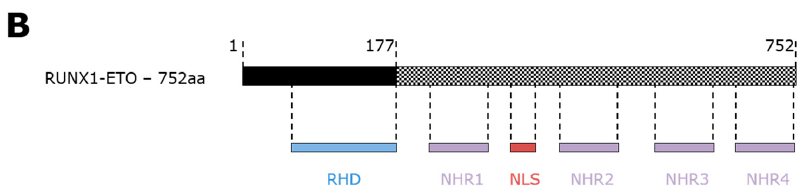
Figure 2. RUNX1-ETO structure and protein domains. ( A ) Schematic diagram of the t(8;21) translocation between the intron 5 of RUNX1 and the intron 1 of ETO. RUNX1-ETO contains 3 exons from the RUNX1 gene and either 9 or 11 exons from the ETO gene. ( B ) Schematic diagram of full-length RUNX1-ETO with the protein domains. The fusion protein has the Runt Homology Domain (RHD), four Nervy Homology Regions (NHRs) and the Nuclear Localization Signal (NLS).